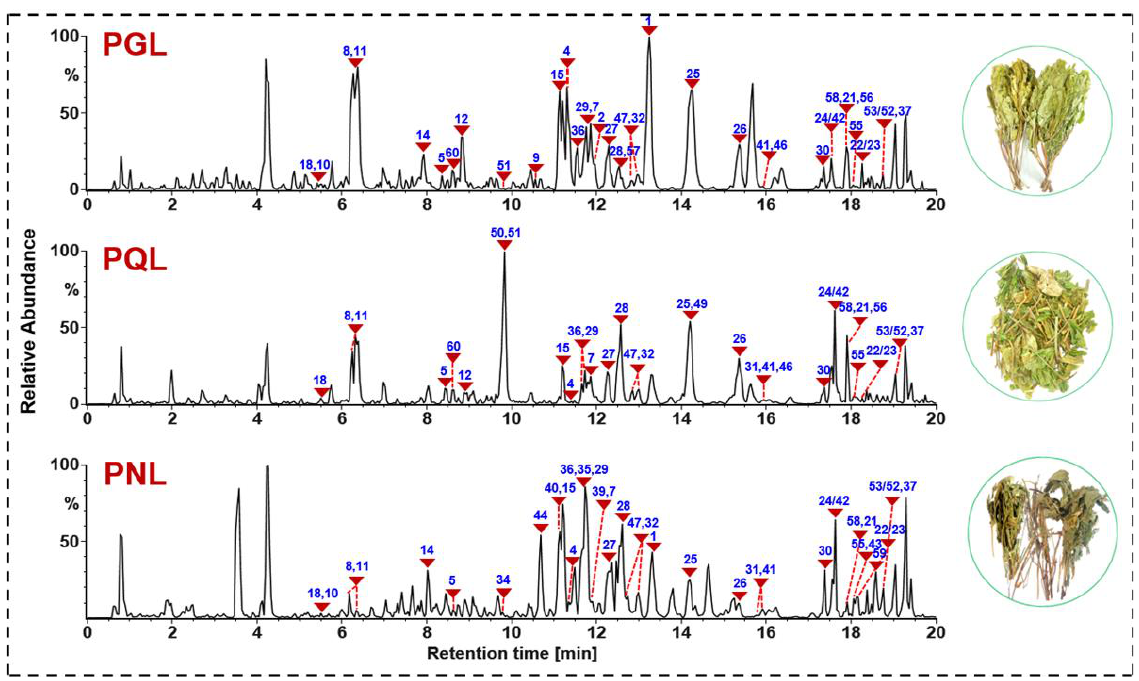
Figure 4. Base peak chromatograms for the representative samples of PGL (PGL-1), PQL (PQL-1), and PNL (PNL-1). The peaks identified by comparison with the reference compounds are annotated with their numbering in Table S1.